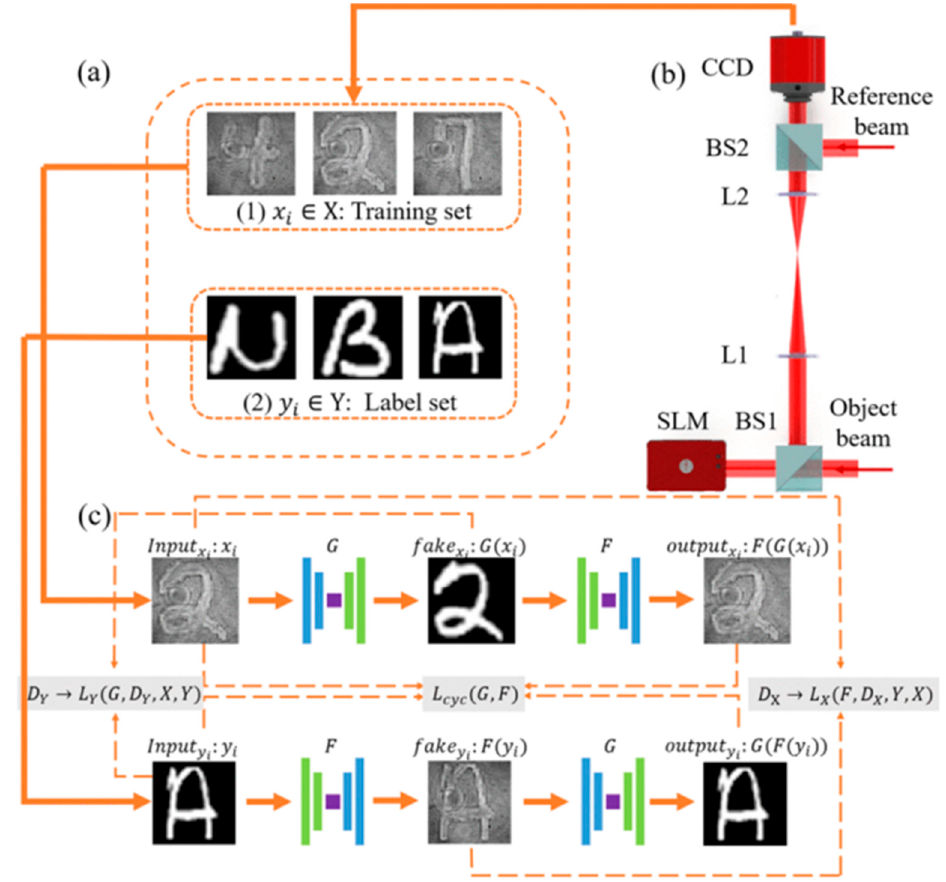
Figure 5. Simplified view of network architecture. ( a ) Training and label set prepared for the network. X i ∈ X: holograms and Y i ∈ Y: labels. ( b ) Partial recording system. ( c ) Overview of training process. Generator function: G and F. D Y : images generated by G indistinguishable from real images. D X : images generated by F indistinguishable from Holograms. Lcyc (D,F): cycle consistency loss. L Y (G,D Y ,X,Y): Adversarial loss between D Y and G. L X (F,D X ,Y,X): Adversarial loss between D X and F [55].